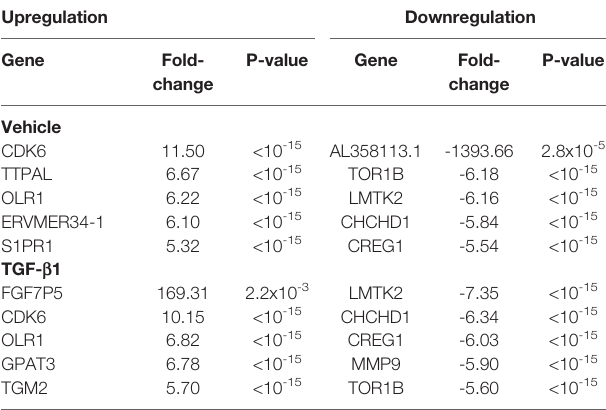
TABLE 1 | List of the genes most affected by LMTK2 KD in CFBE41o- cells treated with TGF- b 1 or vehicle control. Upregulation